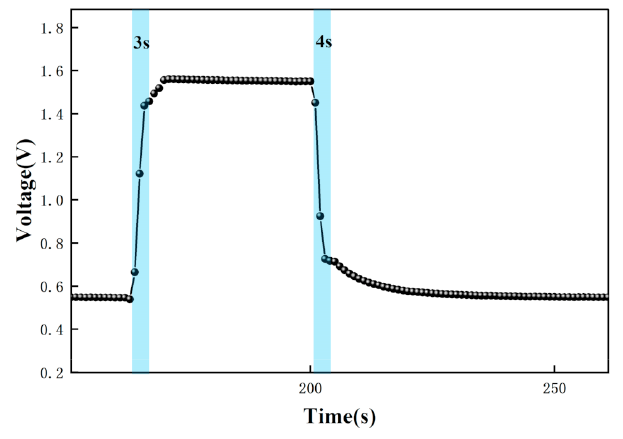
Figure 22. Response recovery time for testing at 20 ppm